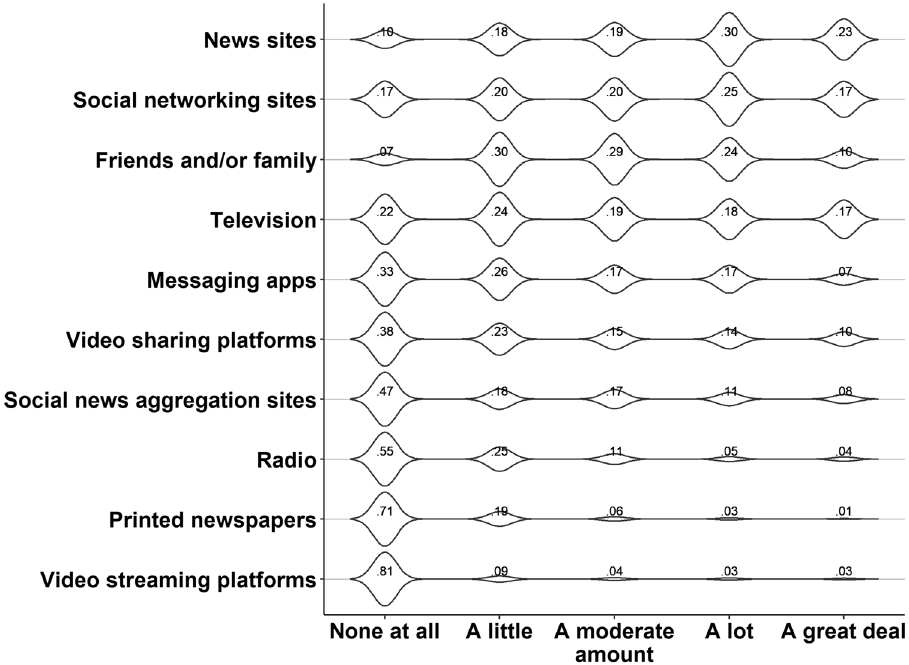
Figure 2. Media use wave 1 . Proportion of respondents (N = 501) that made use of a particular source to acquire COVID-19 information.